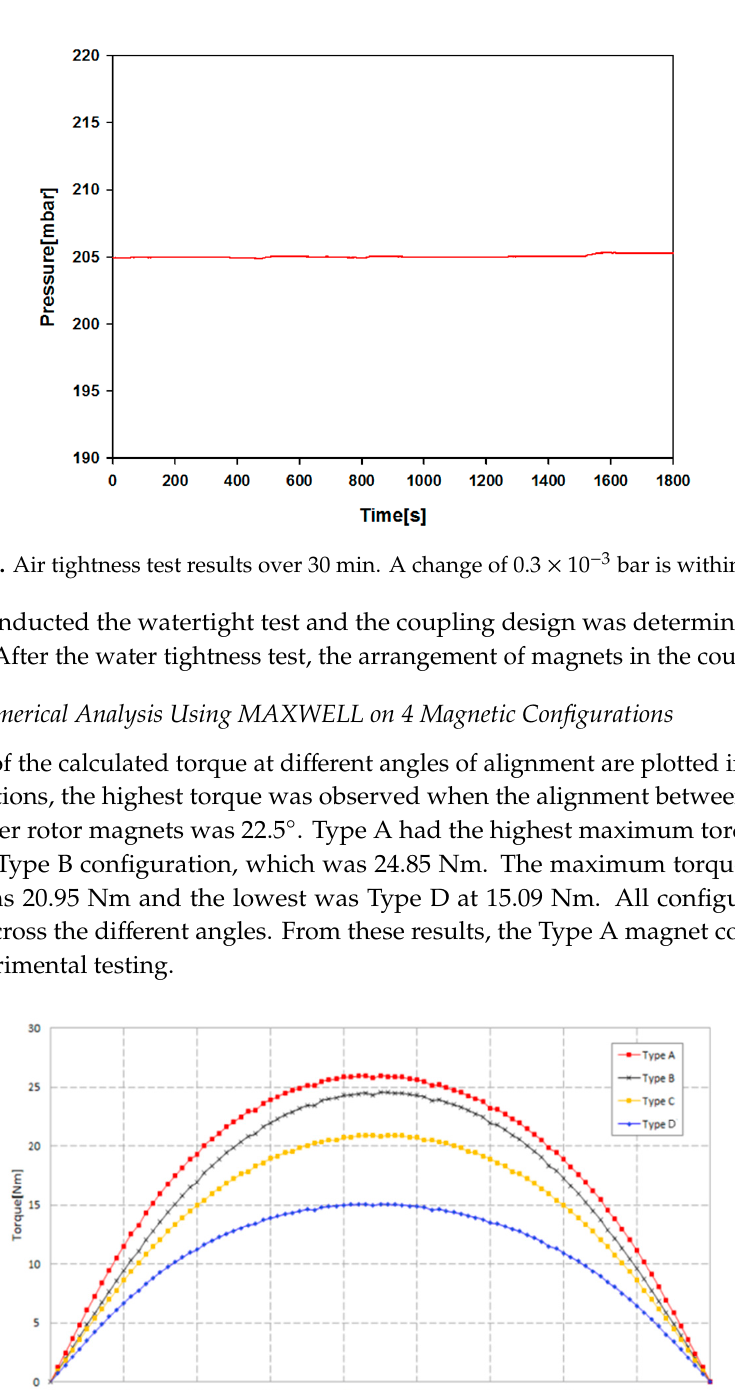
Figure 9. MAXWELL results show the calculated torque at different magnet alignment angles for all configurations.